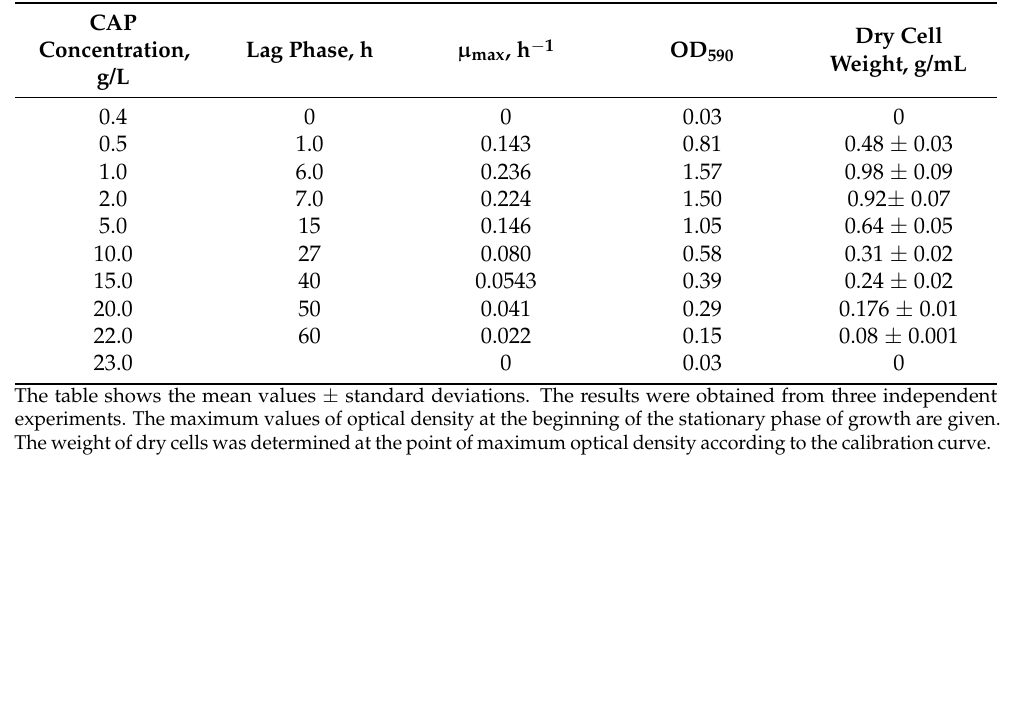
Table 2. Growth values of Brevibacterium epidermidis BS3 vs. caprolactam concentrations in a min- eral